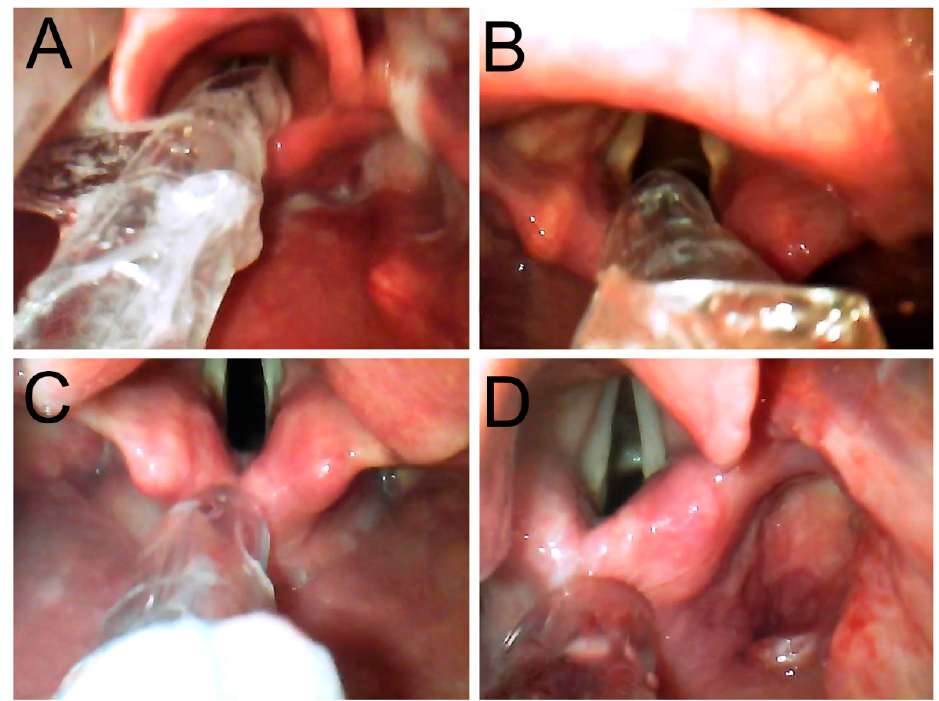
Figure 2. Alignment of nasotracheal tube tip with glottis inlet. The tip of the nasotracheal tube was positioned ( A ) at the center of the glottis inlet, ( B ) between the lower third of the posterior laryngeal wall and corniculate cartilage, ( C ) around the corniculate cartilage, and ( D ) between the posterior laryngeal wall and esophagus.